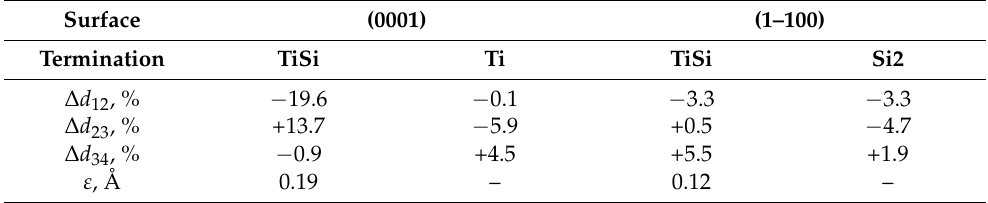
Table 1. Relaxation of the first ( ∆ d 12 ), the second ( ∆ d 23 ) and the third ( ∆ d 34 ) interlayer distances for pure Ti 5 Si 3 surfaces and splitting ε of the first layer.